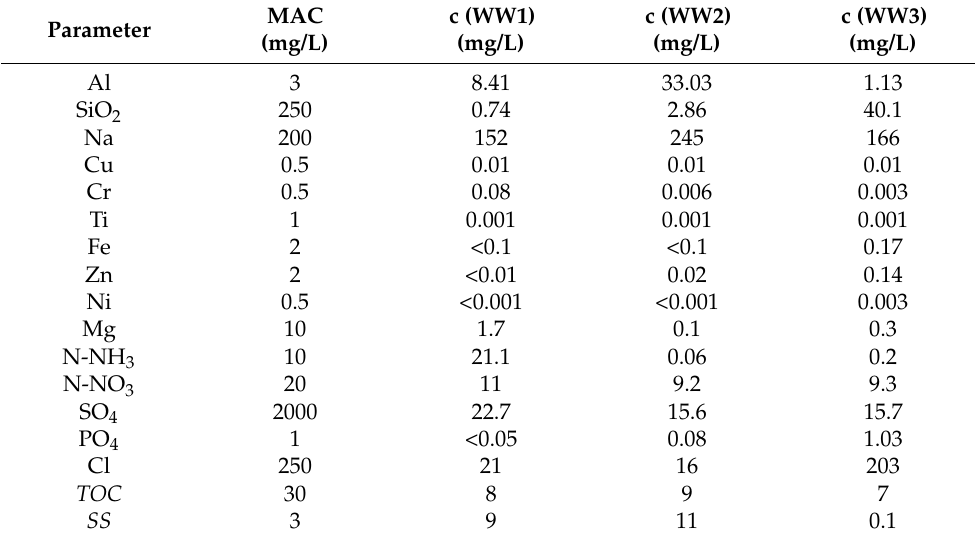
Table 3. Measured chemical parameters after alumina